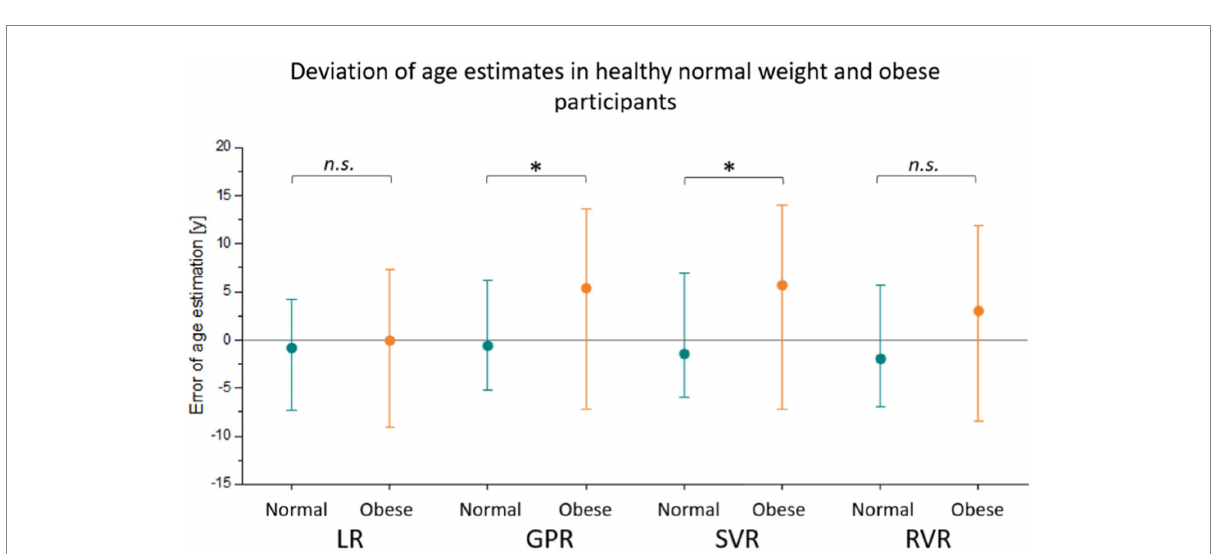
FIGURE 4 Deviation of estimated age from calendar age in a sample of obese participants (orange) and an independent set of matched normal-weight controls (cyan). The median is depicted together with the lower quartile and the upper quartile. Four different models, namely linear regression (LR), Gaussian process regression (GPR), support vector regression (SVR), and relevance vector regression (RVR), were trained on matched normal- weight individuals. The age estimation errors were compared between the normal-weight and obese test set using the Wilcoxon rank-sum test with p-values indicated in the figure [ p < 0.05 (*); p > 0.05